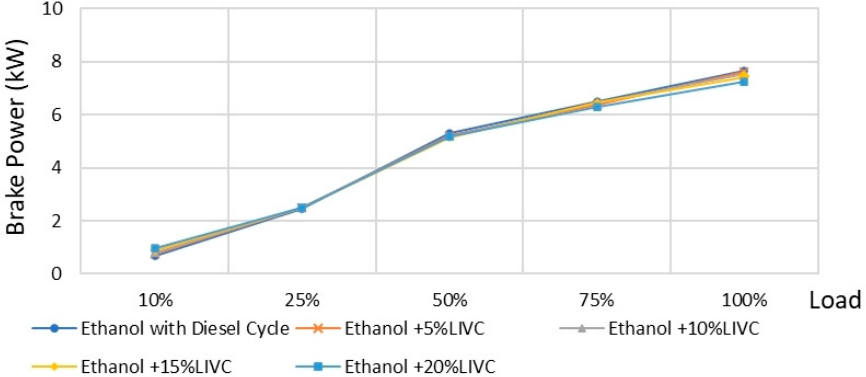
Figure 19. BP(kW) of ethanol engine with LIVC Miller Cycle.